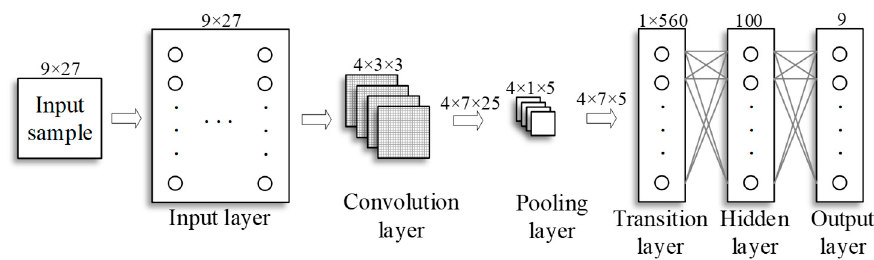
Figure 6. Structural framework of self-supervised CNN model for case study.